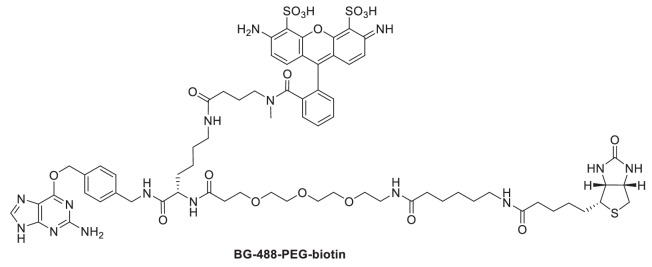
Structure of BG-488-PEG-biotin.